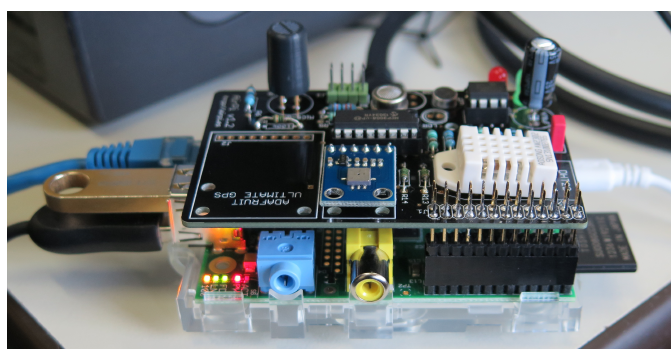
Figure 2. Raspberry Pi Model B with AirPi attached on